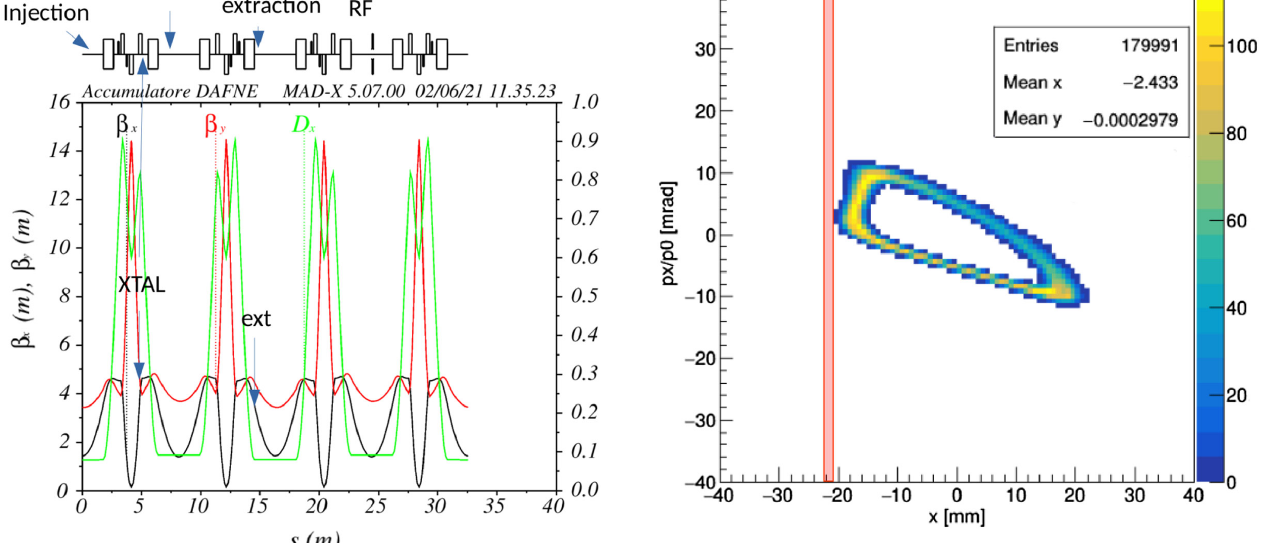
FIG. 3. One possible configuration for the optics Twiss func- tions of the DA Φ NE DR to allow crystal slow extraction.